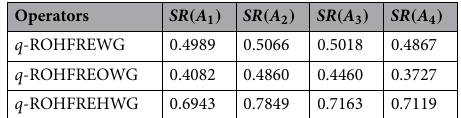
Table 14. Score values.